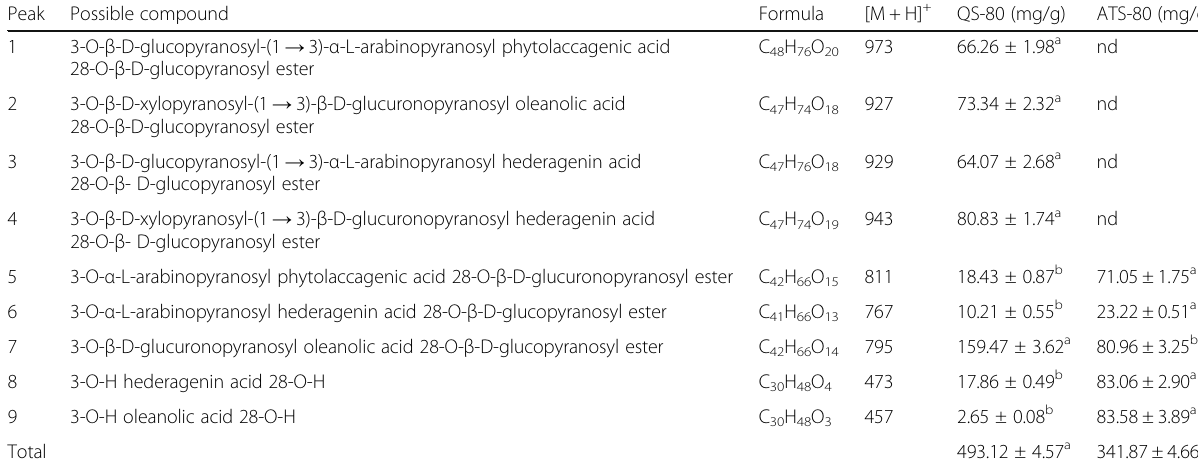
Table 2 Average concentration of saponins in QS-80 and ATS-80 Peak Possible compound